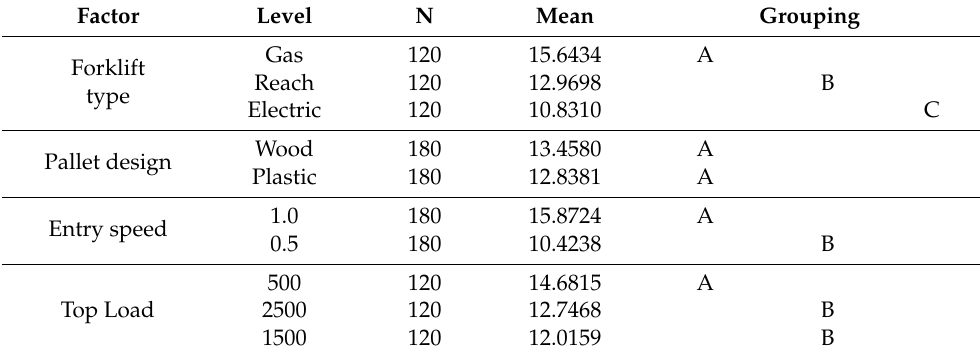
Table A2. Tukey pairwise comparison for pallet acceleration response (Main effects).